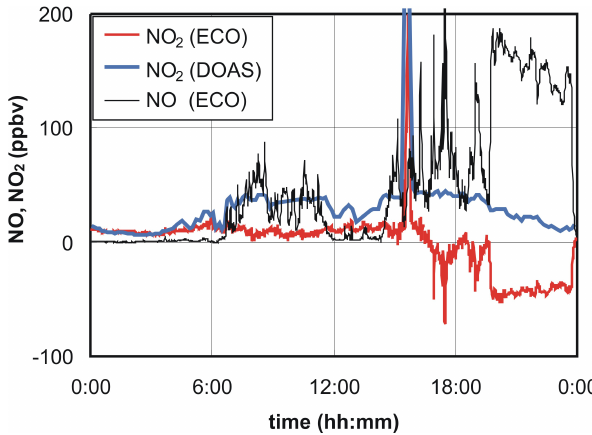
Fig. 2. NO and NO diurnal profiles measured with DOAS and 2 ECO instruments in a tunnel study (Kurtenbach et al., 2001). The spectroscopic DOAS technique was used as a reference for NO this